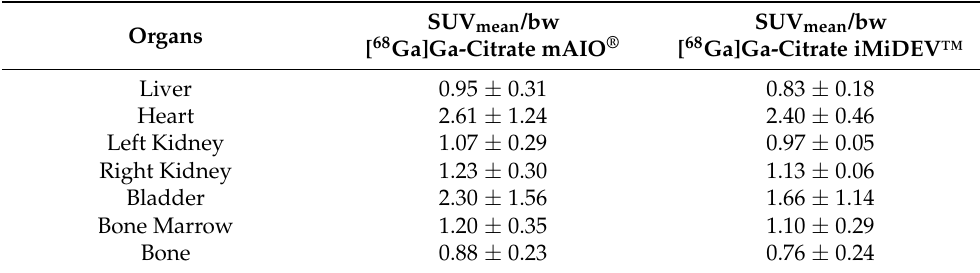
Table 8. Mean standard uptake values (SUV mean ) by body weight (bw) of [ 68 Ga]Ga-citrate in various organs in healthy